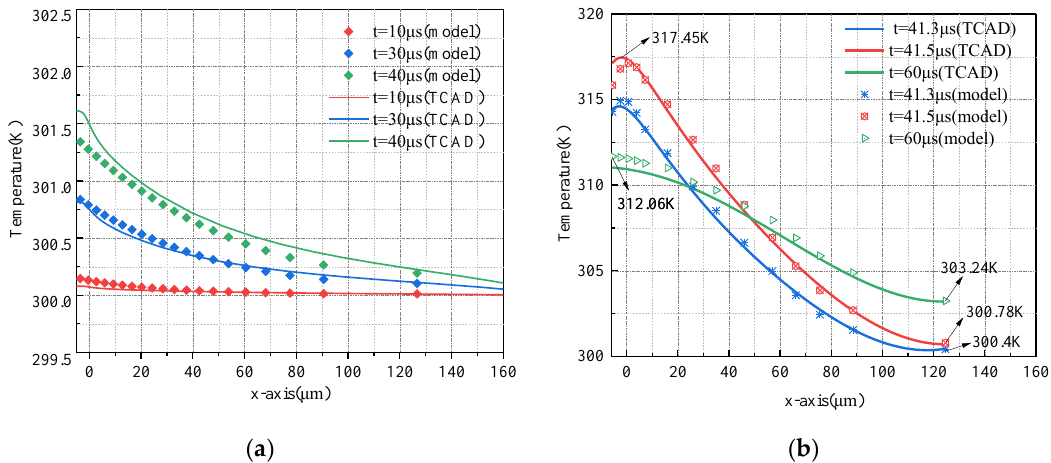
Figure 8. Temperature distribution along chip vertical path ( a ) On-state temperature distribution along chip vertical path. ( b ) Transient temperature distribution along chip vertical path.